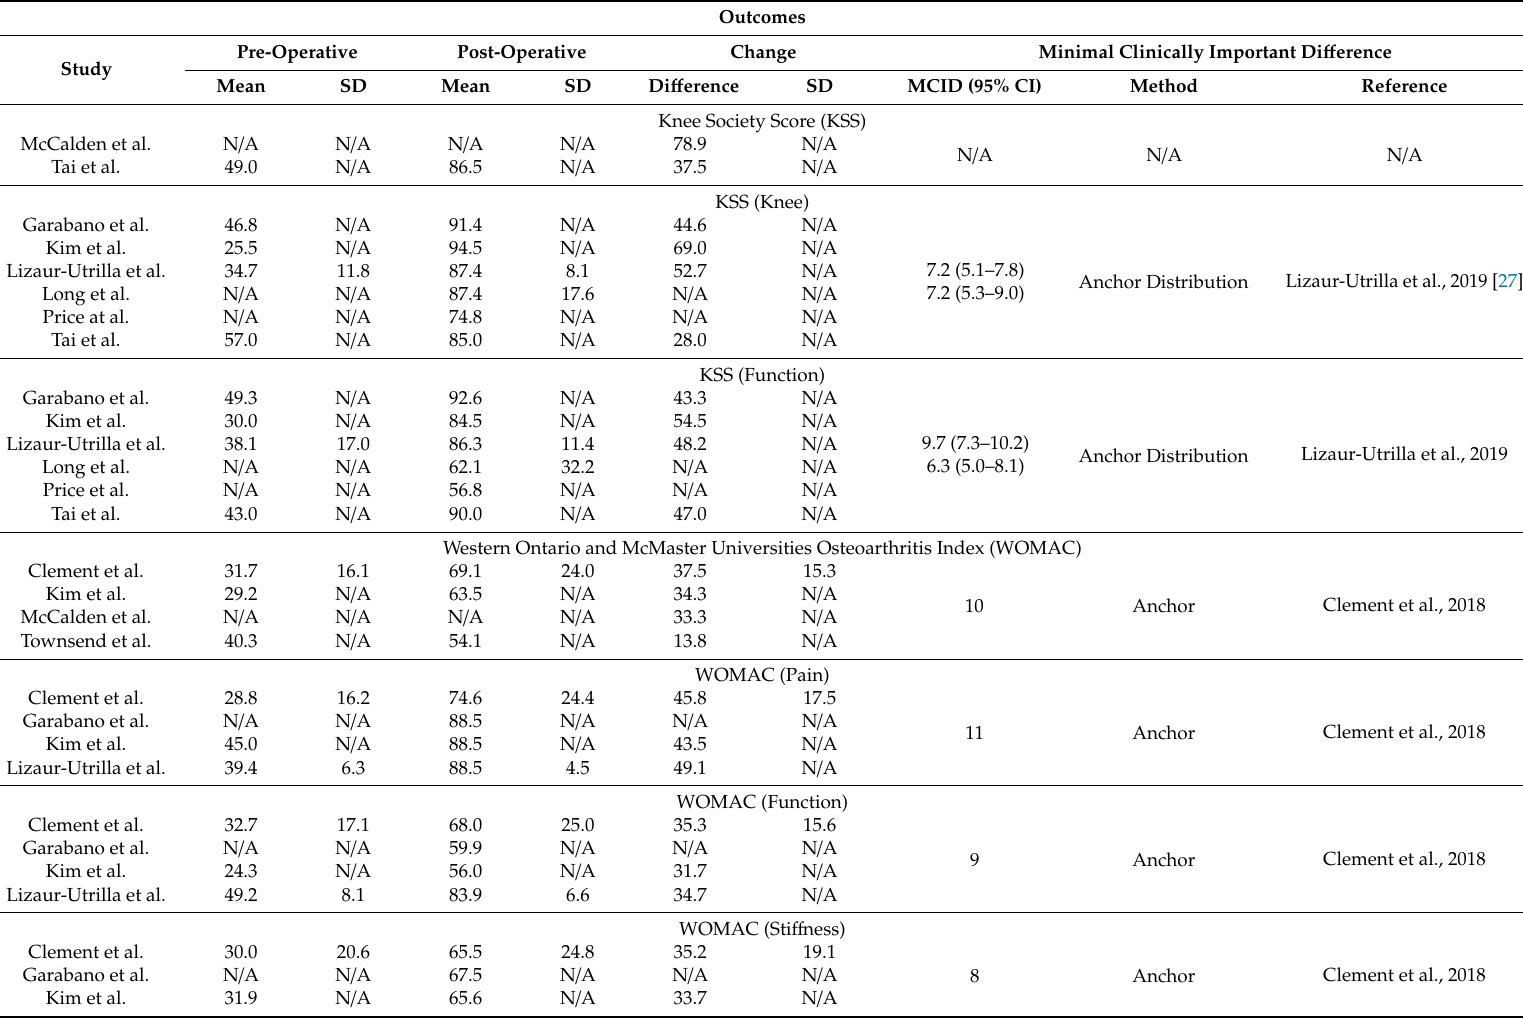
Table 1. Patient-reported outcomes (all instruments standardised to a 0–100